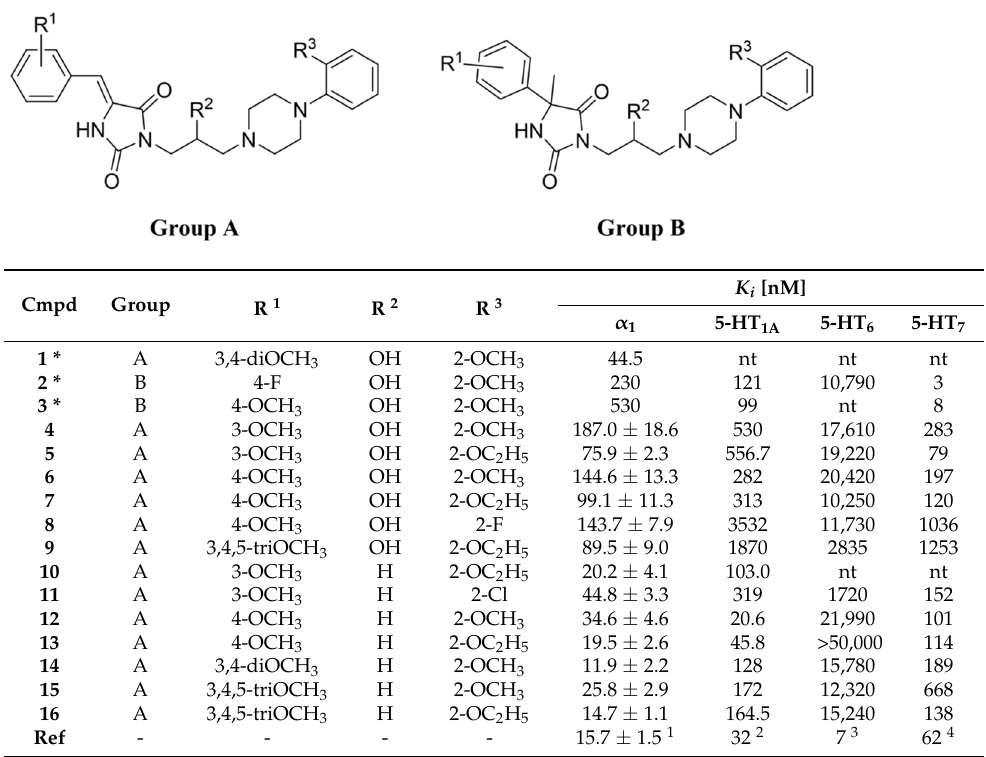
Table 1. Radioligand binding assays results for compounds 1 – 16 .